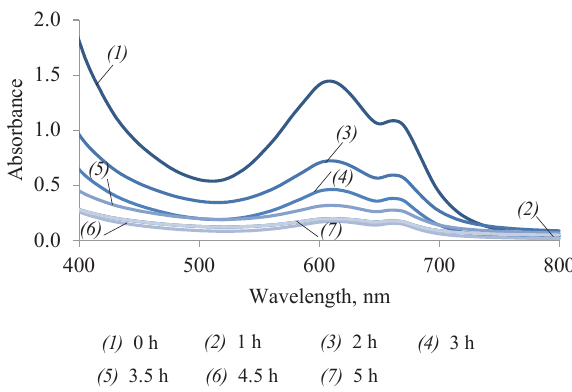
Fig 1: Absorbance of methylene blue at different contact time